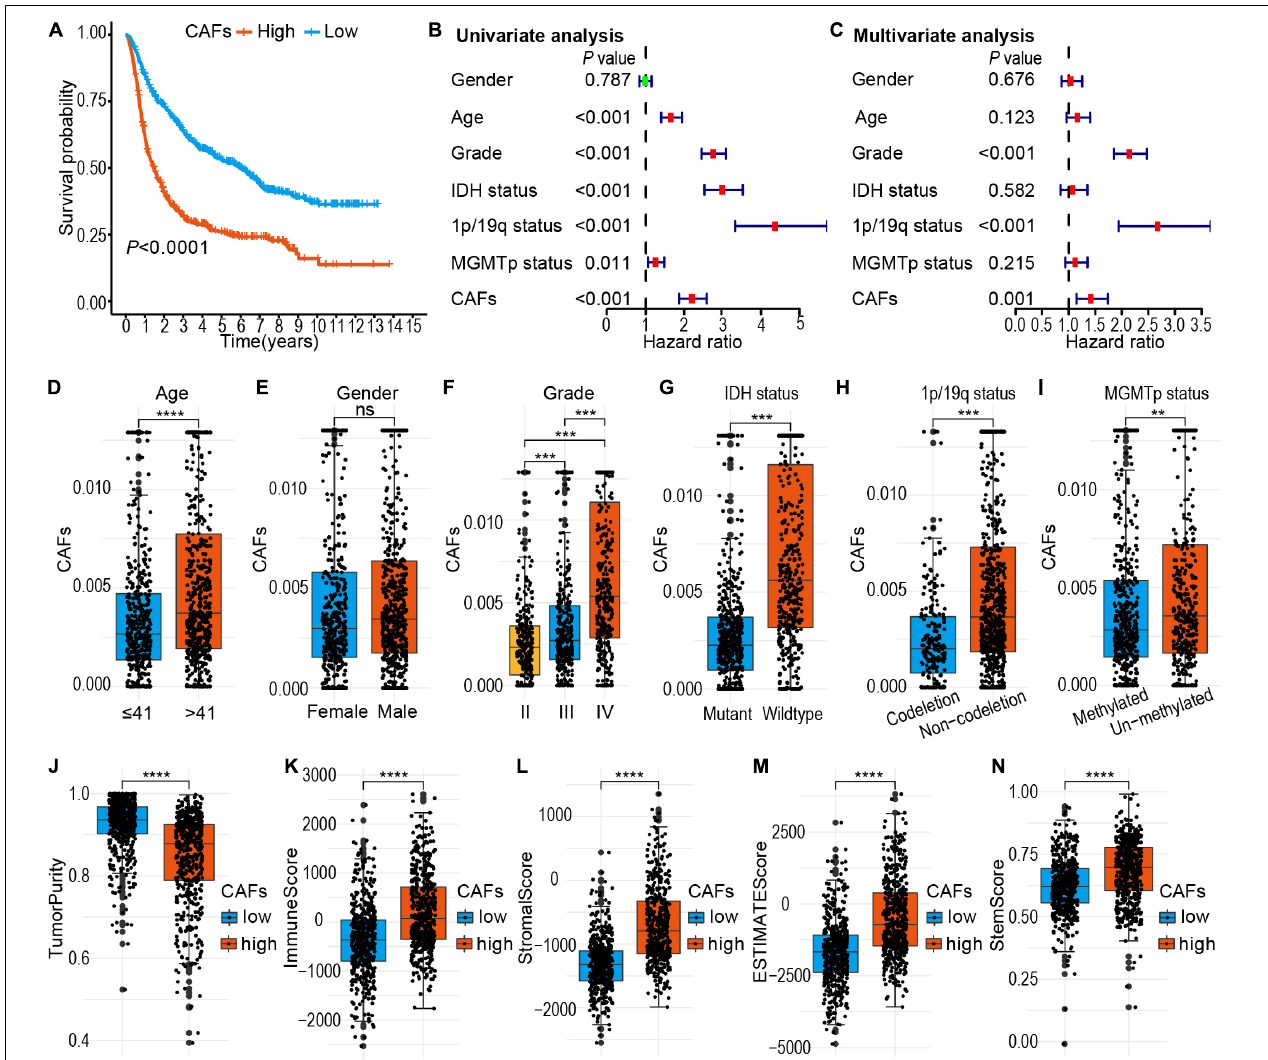
FIGURE 2 | Predictive values of cancer-associated fibroblasts (CAFs) in the survival of glioma patients and its relationship with pathological characteristics. (A) Comparison of overall survival between low and high CAFs subtypes in the Chinese Glioma Genome Atlas (CGGA) database. (B) Univariate Cox regression analysis. Forest plot of the association between CAFs and glioma survival. (C) Multivariate Cox regression analysis showed that the CAFs was an independent predictor of gliomas. (D–N) Distribution of the CAFs in patients stratified according to age (D) , gender (E) , WHO grade (F) , isocitrate dehydrogenase (IDH) status (G) , 1p/19q status (H) , O-6-methylguanine-DNA methyltransferase (MGMT) promoter status (I) , Tumor purity (J) , Immune score (K) , Stromal score (L) , ESTIMATE score (M) , and Stemness score (N) . **** P < 0.0001; *** P < 0.001; ** P < 0.01; ns, no significant.